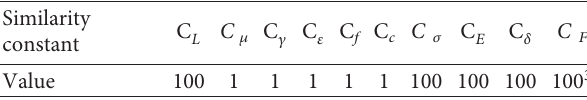
Figure 1: Model similar material testing process. Table 4: Model similarity parameter